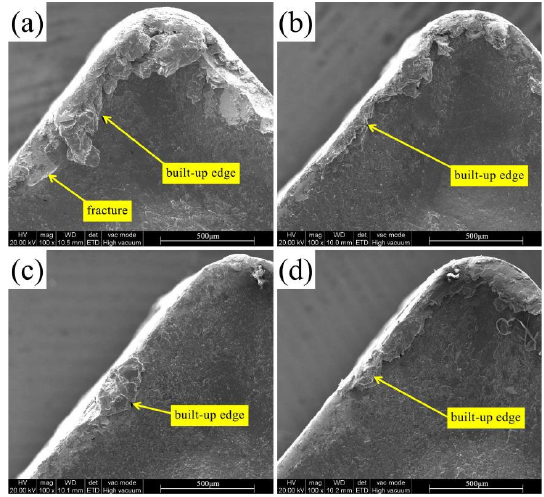
Figure 16. Wear of the rake face using (TiAl)N-coated inserts: ( a ) CT; ( b ) 0.42 A/mm 2 ; ( c ) 0.57 A/mm 2 ; and ( d ) 0.90 A/mm 2 .